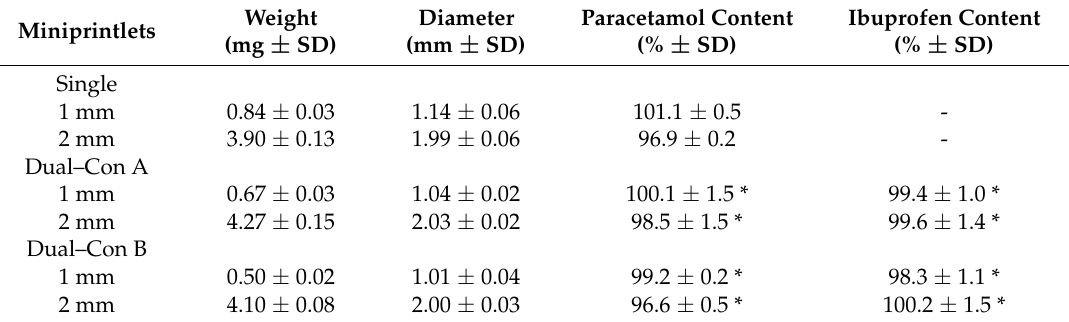
Table 2. Characteristics of the miniprintlets (SD—standard